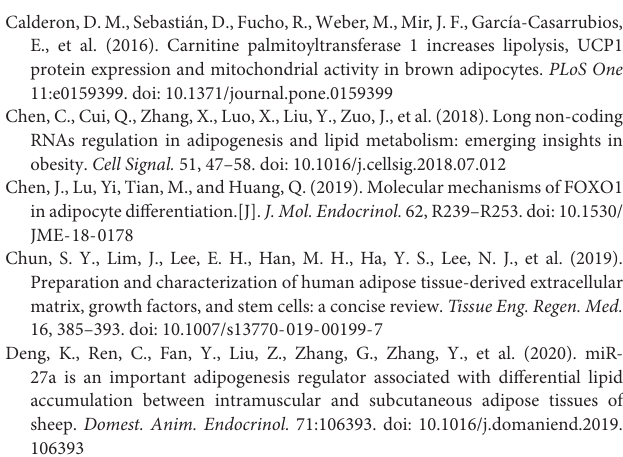
Supplementary Table 1 | Primer sequences of mRNAs. Supplementary Table 2 | Primer sequences of LncRNAs. Supplementary Table 3 | Primer sequences of circRNAs. Supplementary Table 4 | Primer sequences of miRNAs. Supplementary Table 5 | List of 1,196 DEmRNAs. Supplementary Table 6 | List of 754 DELncRNAs. Supplementary Table 7 | List of 17 DEcircRNAs. Supplementary Table 8 | List of 100 DEmiRNAs. Supplementary Table 9 | Data of LncRNA binds to miRNA. Supplementary Table 10 | Data of LncRNA binds to mRNA. Supplementary Table 11 | Data of circRNA absorbs miRNA. Supplementary Table 12 | Data of miRNA bind to mRNA. Supplementary Table 13 | LncRNA-mRNA-miRNA correlation data. Supplementary Table 14 | circRNA-mRNA-miRNA correlation data. Supplementary Table 15 | circRNA-LncRNA-mRNA-miRNA correlation